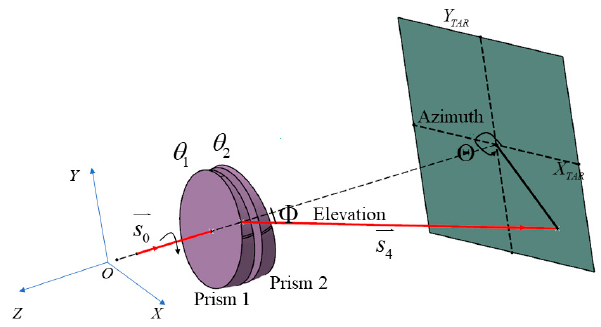
Figure 2. Beam deflection by a rotational double prism system.